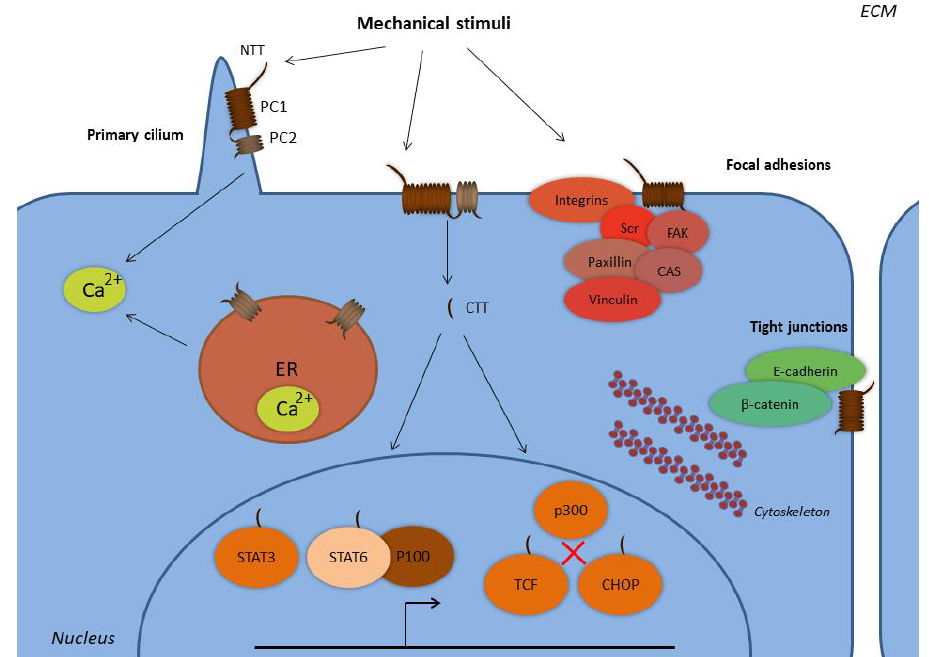
Figure 1. Subcellular localization of polycystins. Abbreviations: CHOP, C/EBP homologous protein; CTT, C-terminal tail; ER, endoplasmic reticulum; FAK, focal adhesion kinase; NTT, N-terminal tail; PC1, polycystin-1; PC2, polycystin-2; STAT, signal transducer and activator of transcription; TCF, T-cell factor. PC1 and PC2 form complexes at the primary cilium and at the plasma membrane, where PC1 senses extracellular mechanical stimuli with its N-terminal tail. PC1 is expressed at the focal adhesion complexes regulating cell-to-ECM interactions, along with proteins such as integrins, Src, focal adhesion kinase (FAK), paxillin, p130Cas, and vinculin. PC1 is also expressed in complexes with E-cadherin and β-catenin at the tight junctions regulating cell-to-cell interactions. The PC1 C-terminal tail is subjected to proteolytic cleavages and translocates to the nucleus, where it forms complexes with the transcription factors STAT3 and STAT6, and the coactivator p100. The PC1 CTT interacts with TCF and CHOP transcription factors in order to abolish their interactions with the p300 coactivator. PC2 is also expressed at the endoplasmic reticulum and regulates the concentration of the intracellular calcium.